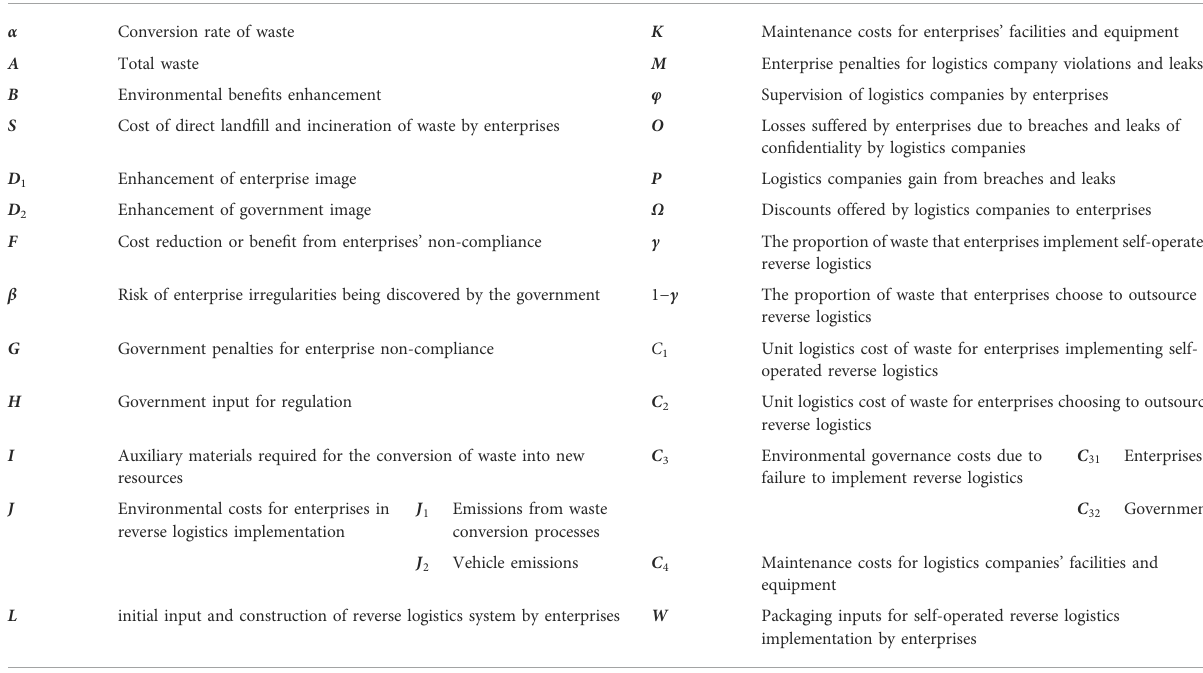
TABLE 1 Parameter settings related to the game model.